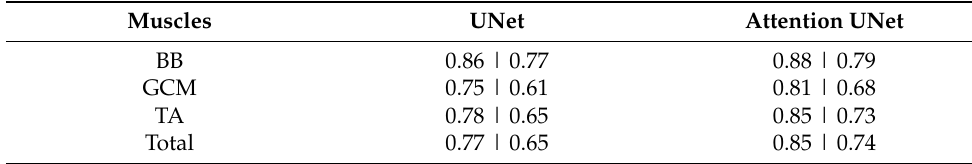
Table 1. Results of UNet and Attention UNet in terms of Dice Coeff | IoU.